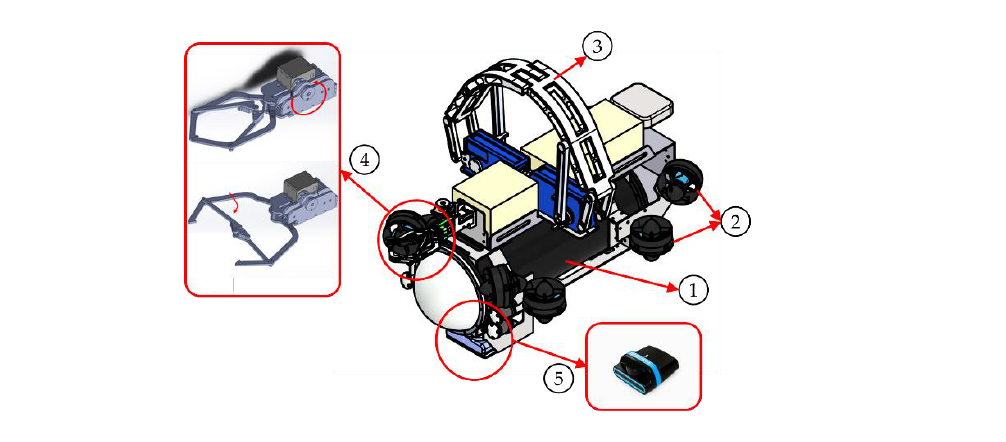
Figure 2. The proposed ROV for retrieving the underwater glider. (1) Main body; (2) Thrusters; (3) Clamp; (4) Gripper; (5) Stereo camera.